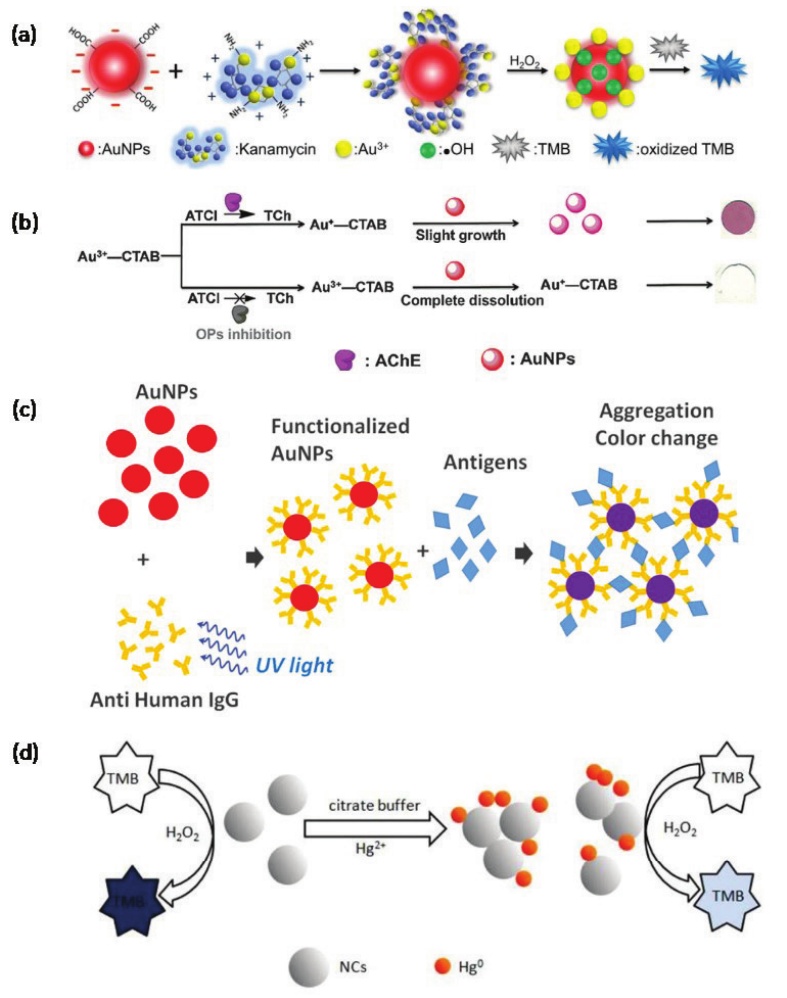
Figure 1: (a) Schematic diagram of AuNPs-based colorimetric detection of kanamycin. Reprinted image with permission from Ref. [20], Copyright 2016, Elsevier B.V. (b) Schematic diagram of OPs colorimetric analysis based on AuNPs dissolution. Reprinted image